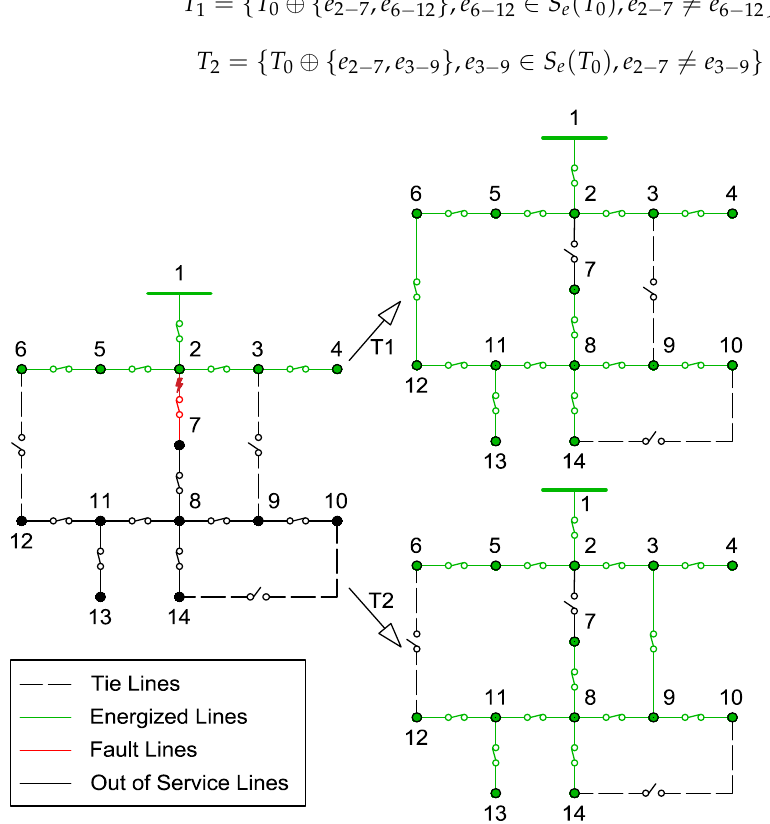
Figure 4. IEEE 13 node modified test